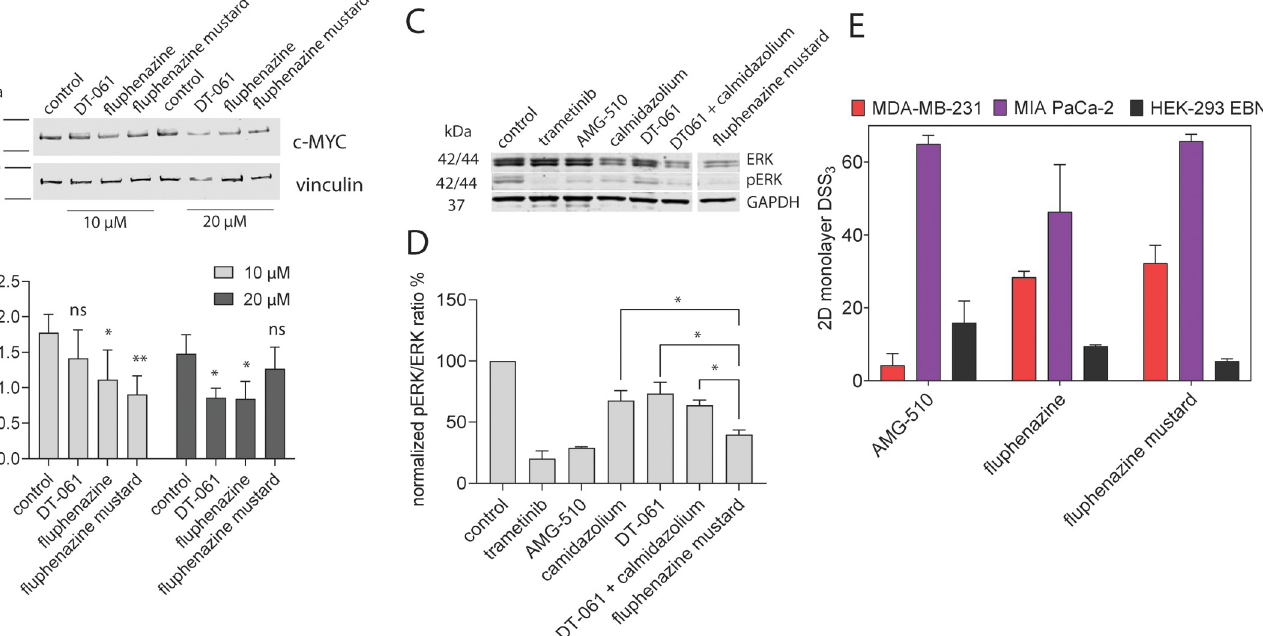
PLOS ONE | https://doi.org/10.1371/journal.pone.0268635 May 26,